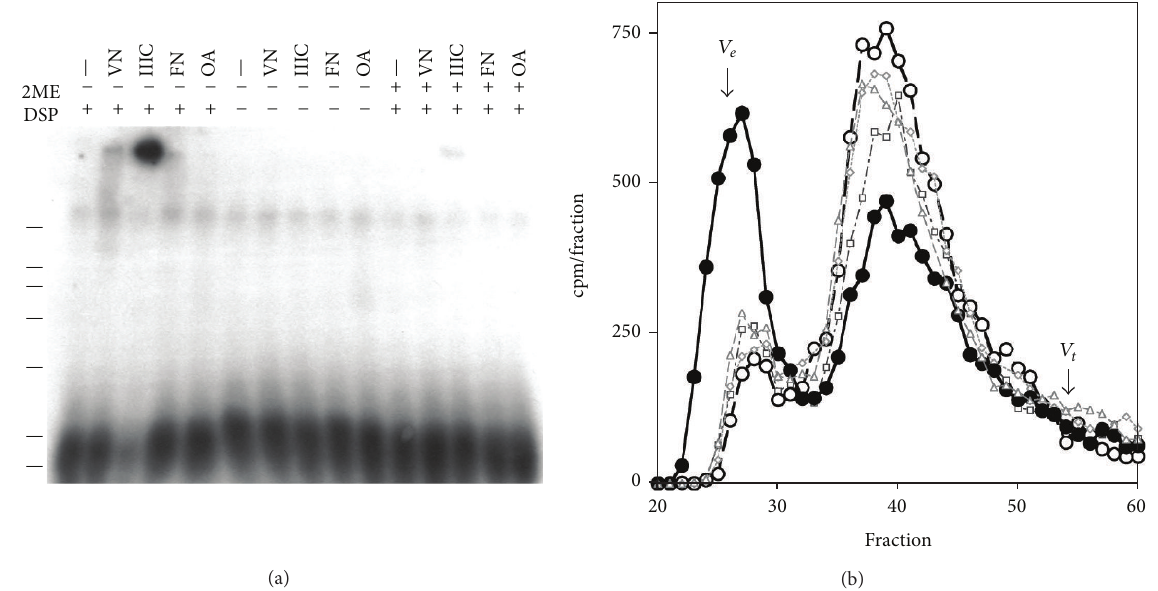
Figure 3: MGP is crosslinked by DSP to vitronectin, fibronectin, and fibronectin III1-C polypeptide. (a) SDS-PAGE of DSP crosslinking reaction products of unlabeled proteins incubated with trace amounts of radioactive MGP. The presence of the crosslinker DSP, reducing agent 2-mercaptoethanol (2ME), is indicated by + or − in the appropriate lane. The protein present in the reaction is indicated above the lane; − , no added protein; VN, vitronectin; IIIC fibronectin III1-C polypeptide; FN, fibronectin; and OA, ovalbumin. (b) Gel filtration column separation of DSP crosslinked MGP and Fibronectin III1-C. Lines indicate 7 marker positions of 200, 116, 97, 66, 43, 31, and 14 kDa. DSP reacted sample containing labeled MGP and unlabeled III1-C( e ); DSP reacted solution containing labeled MGP and unlabeled III1-Creduced with mercaptoethanol prior to column loading, ( ⃝ ); labeled MGP alone ( 󳵻 ); Labeled MGP and unlabeled III1-C incubated with DSP vehicle (DMSO) ( ◊ ); DSP reacted solution containing labeled MGP alone ( ◻ ). The exclusion volume 𝑉 𝑒 was estimated by blue dextran elution, and total volume 𝑉 𝑡 was estimated by phenol red elution. The column was run with 4 M guanidine containing buffer to disassociate noncovalent interactions (see